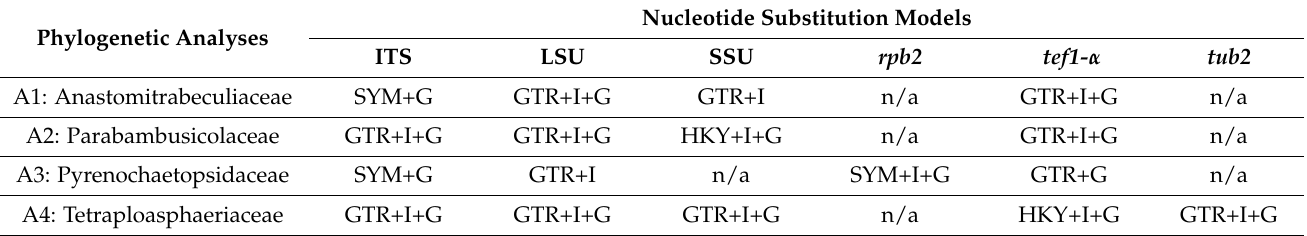
Table 2. The best nucleotide substitution model for each locus based on the Akaike Information Criterion (AIC) generated by MrModeltest v.